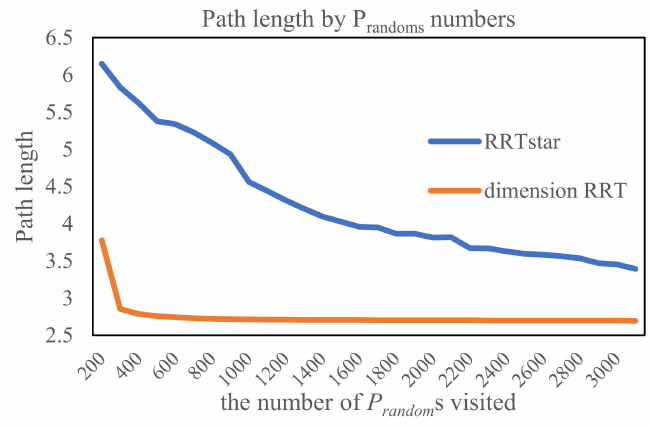
Figure 15. Path length by P random s